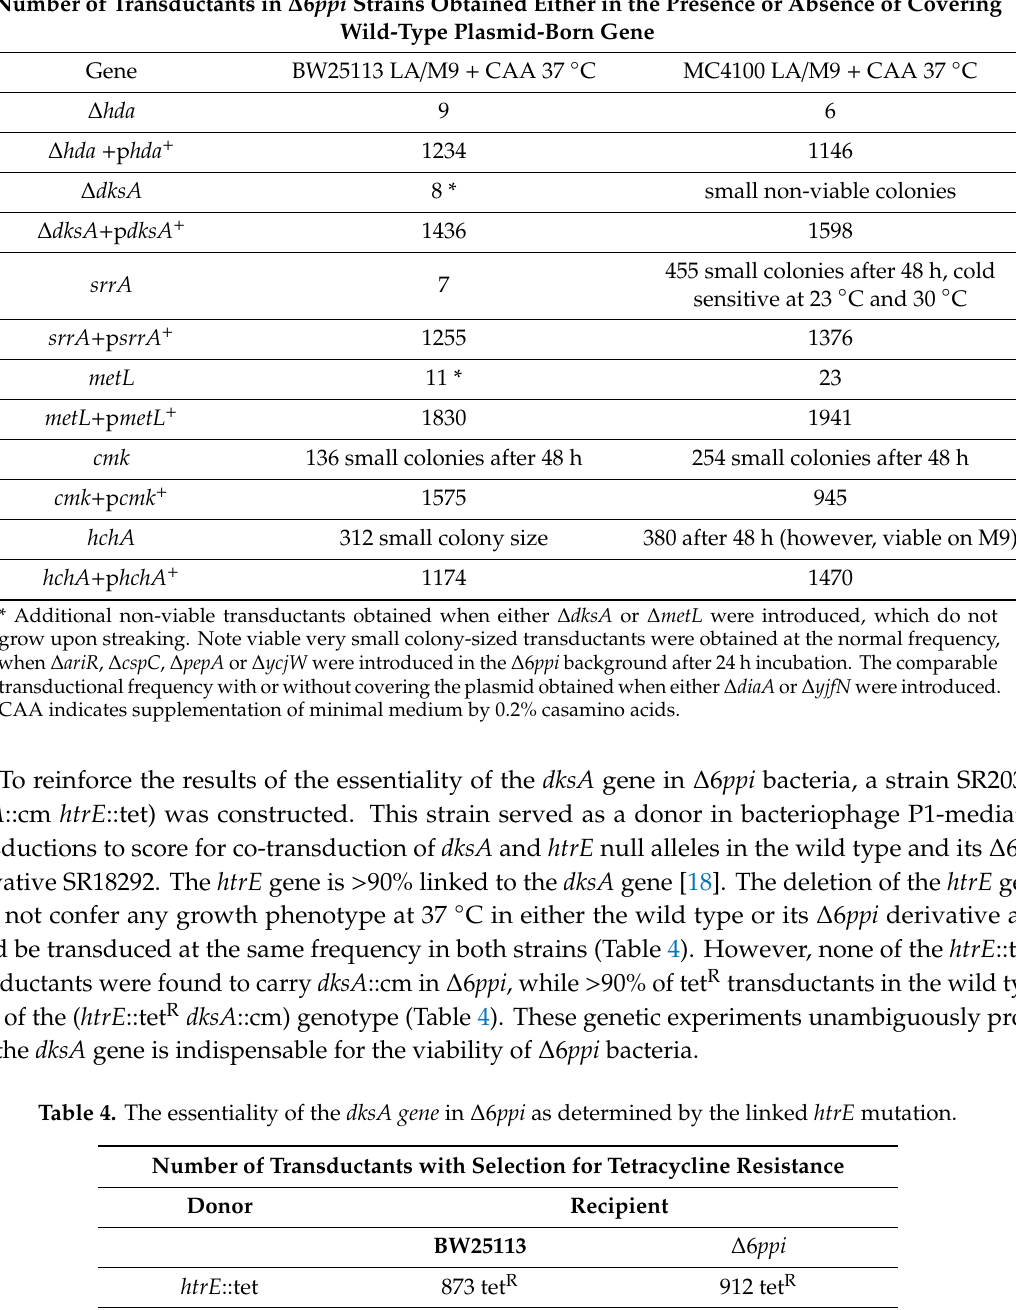
Table 3. The essentiality of dksA , srrA , hda , cmk , metL genes and a partial requirement for HchA in ∆ 6 ppi strains.